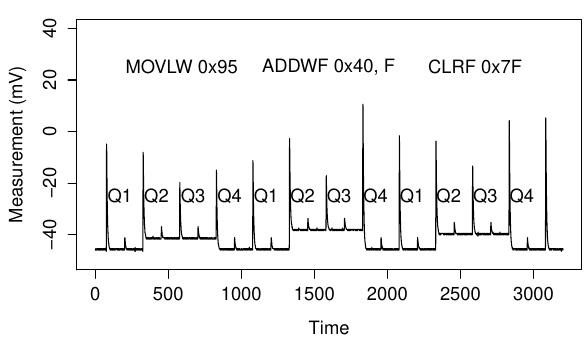
Figure 2. A single captured power measurement executing { MOVLW 0x95; ADDWF 0x40, F; CLRF 0x7F }. The x-axis is time and the y-axis is voltage drop. The oscilloscope offset to -60 mV to span the vertical